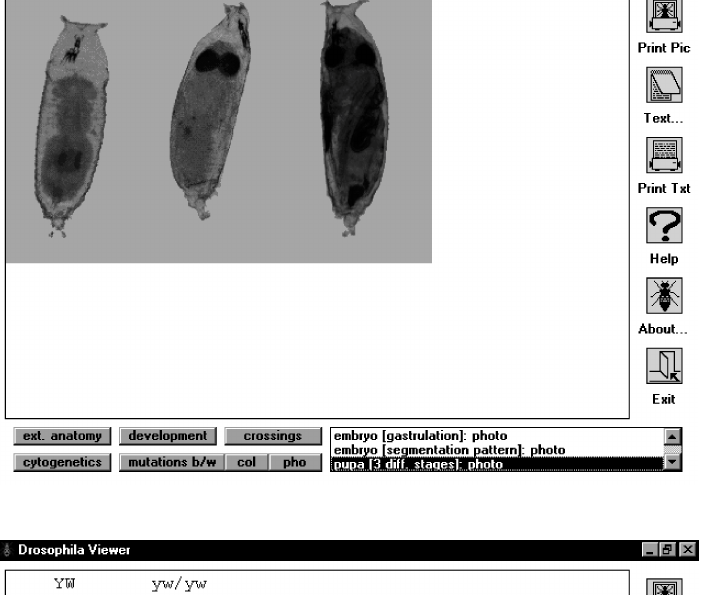
Figure 4 - Color drawing (original) showing the insertion of main bristles of head and thorax in a wild-type fly. The picture was selected by clicking the item in the list shown on the right after pressing the command button “ext(ernal). anatomy.”